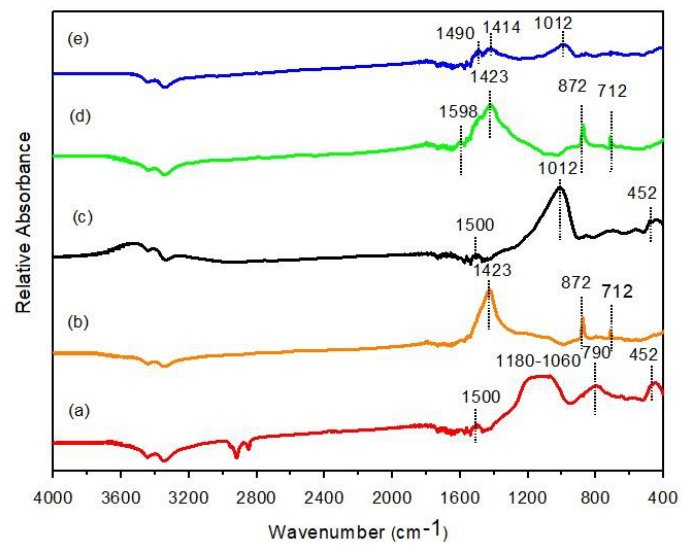
Figure 5. Fourier Transform Infrared Spectroscopy (FTIR) spectra of the raw materials ( a ) metakaolin, ( b ) marble waste, and the AAMs ( c ) MK, ( d ) MW, and ( e ) MW/MK 0.3, produced under the optimum conditions (H 2 O/Na 2 O molar ratio 16, curing temperature 40 °C, curing period 24 h).